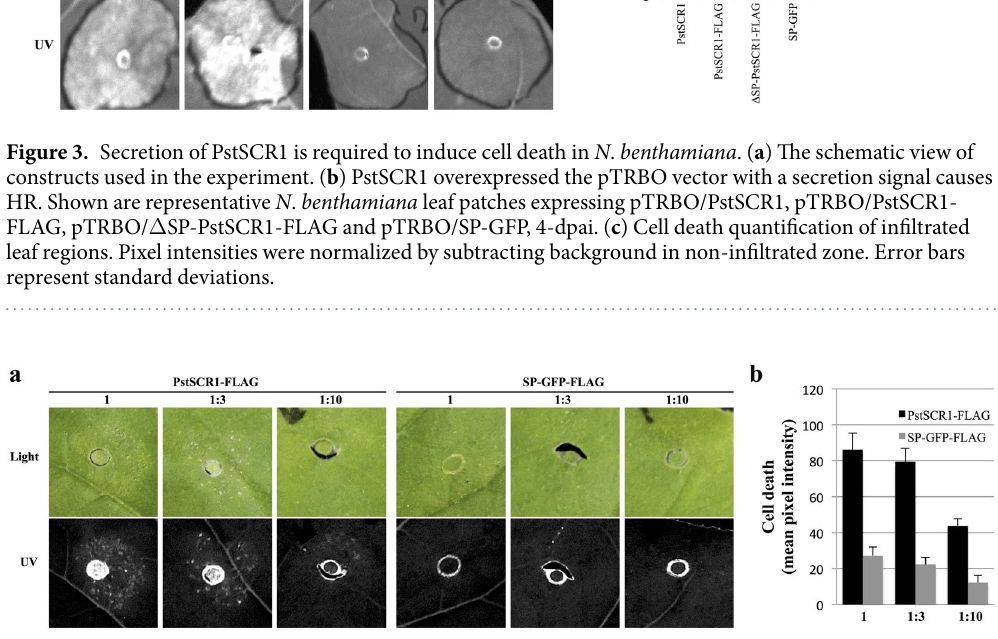
Figure 4. Apoplastic fluid containing the secreted PstSCR1 triggers cell death in N . benthamiana in a dose- dependent manner. The infiltration of N . benthamiana was conducted with apoplastic fluid containing processed PstSCR1. ( a ) Shown is a representative leaf of N . benthamiana infiltrated with apoplastic fluid (with no dilution (600–700 μ g/ μ L), 1:3 and 1:10 dilutions in ddH 2 O) from N . benthamiana expressing PstSCR1-FLAG and SP-GFP-FLAG. Four days after apoplastic fluid infiltration, the leaves were examined under normal light and UV exposure. ( b ) Cell death quantification of infiltrated leaf regions. Pixel intensities were normalized by subtracting background in non-infiltrated zone. Error bars represent standard